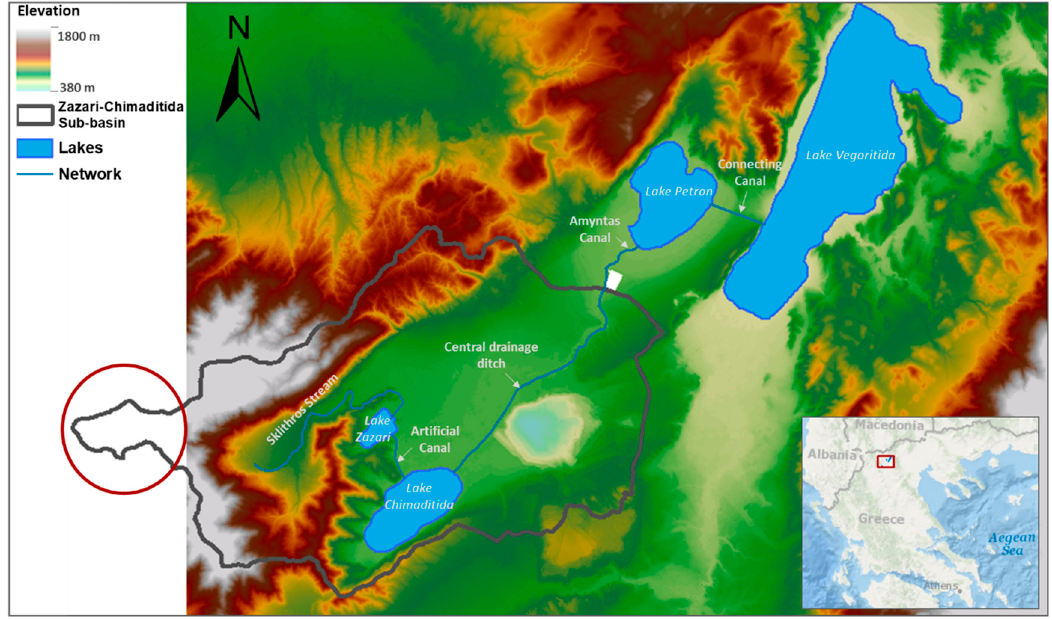
Figure 2. Hydrological catchment of Lakes Zazari-Chimaditida, along with the hydrographic network. The red circle indicates the part of the digital elevation model that has been excluded from the analyses.